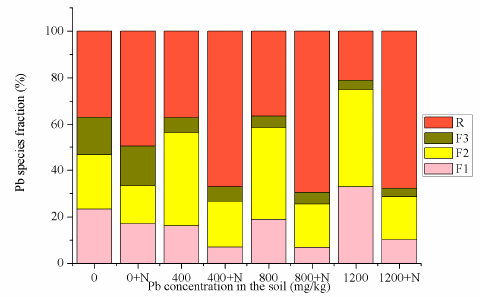
Figure 1. Lead partitioning in Pb-spiked soil with and without NHAP application. The values of 0, 400, 800, 1200 respectively stand for the addition of Pb content (0, 400, 800, 1200 mg/kg); 0 + N, 400 + N, 800 + N, 1200 + N respectively stand for the addition of Pb content (0, 400, 800, 1200 mg/kg) and NHAP (1.5 g). The operationally defined soil fractions were: (F1) exchangeable, (F2) reducible (iron/manganese oxyhydroxides), (F3) oxidizable (organic matter and sulfides), and (R) residual. N: nano-hydroxyapatite.